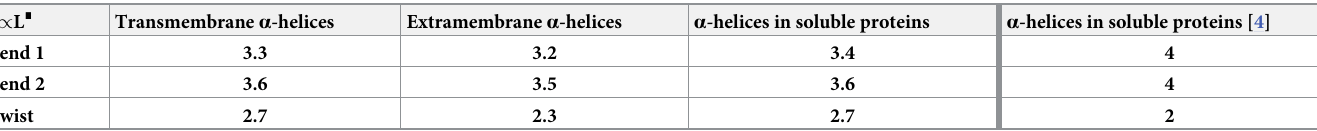
Table 1. The scaling exponents derived from a power law relationship between the eigenvalues ( λ ) of the first three deformation modes and the α -helix length ( L ). λ / L